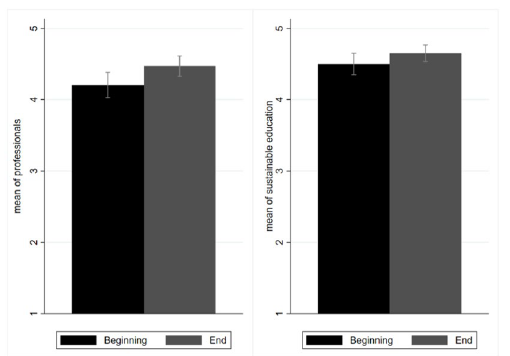
Figure 7. Mean values for sustainable education and the need for new professionals to support the green transition. Black bars represent values recorded at the beginning of the course and grey bars represent values recorded at the end of the course. Values range from 1 to 5, according to the Likert